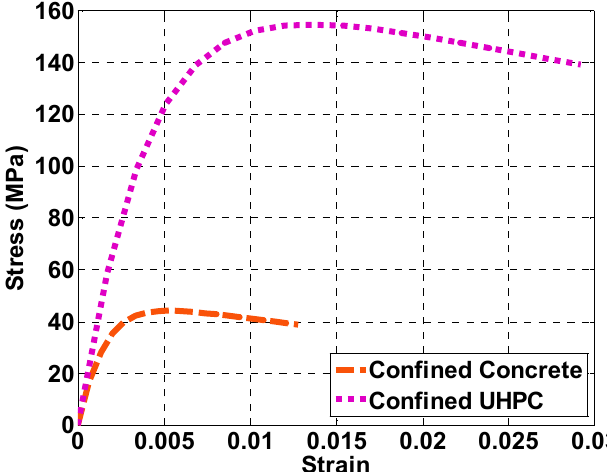
Figure 3. Stress-strain behavior of confined concrete and UHPC.